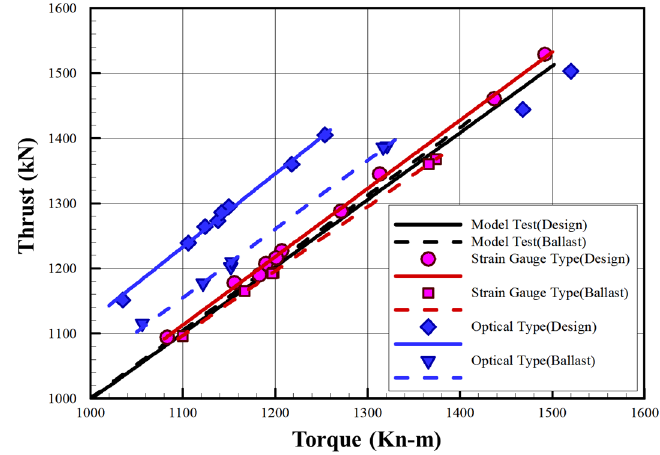
Figure 10. Comparison of thrust–torque of crude oil tankers.